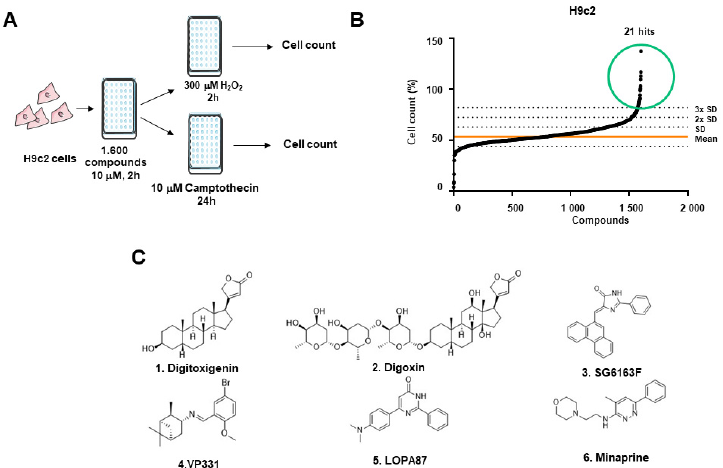
Figure 1. High-throughput screening for cardiac apoptosis and necrosis inhibitors. ( A ) Flow chart of the screening. Immortalized H9c2 cells were plated into 96-well plates, treated by 1600 compounds for 2 h, then by 10 µ M camptothecin for 24 h or 300 µ M H 2 O 2 for 2 h. ( B ) Cell survival was determined by methylene blue staining, percentage of survived cells was calculated in comparison to 0.1% DMSO as the vehicle and used to rank the compounds. ( C ) Ranked list and chemical formula of 6 best hits selected from Prestwick (hits 1, 2, and 6) and SBM CEA libraries (hits 3, 4, and 5).